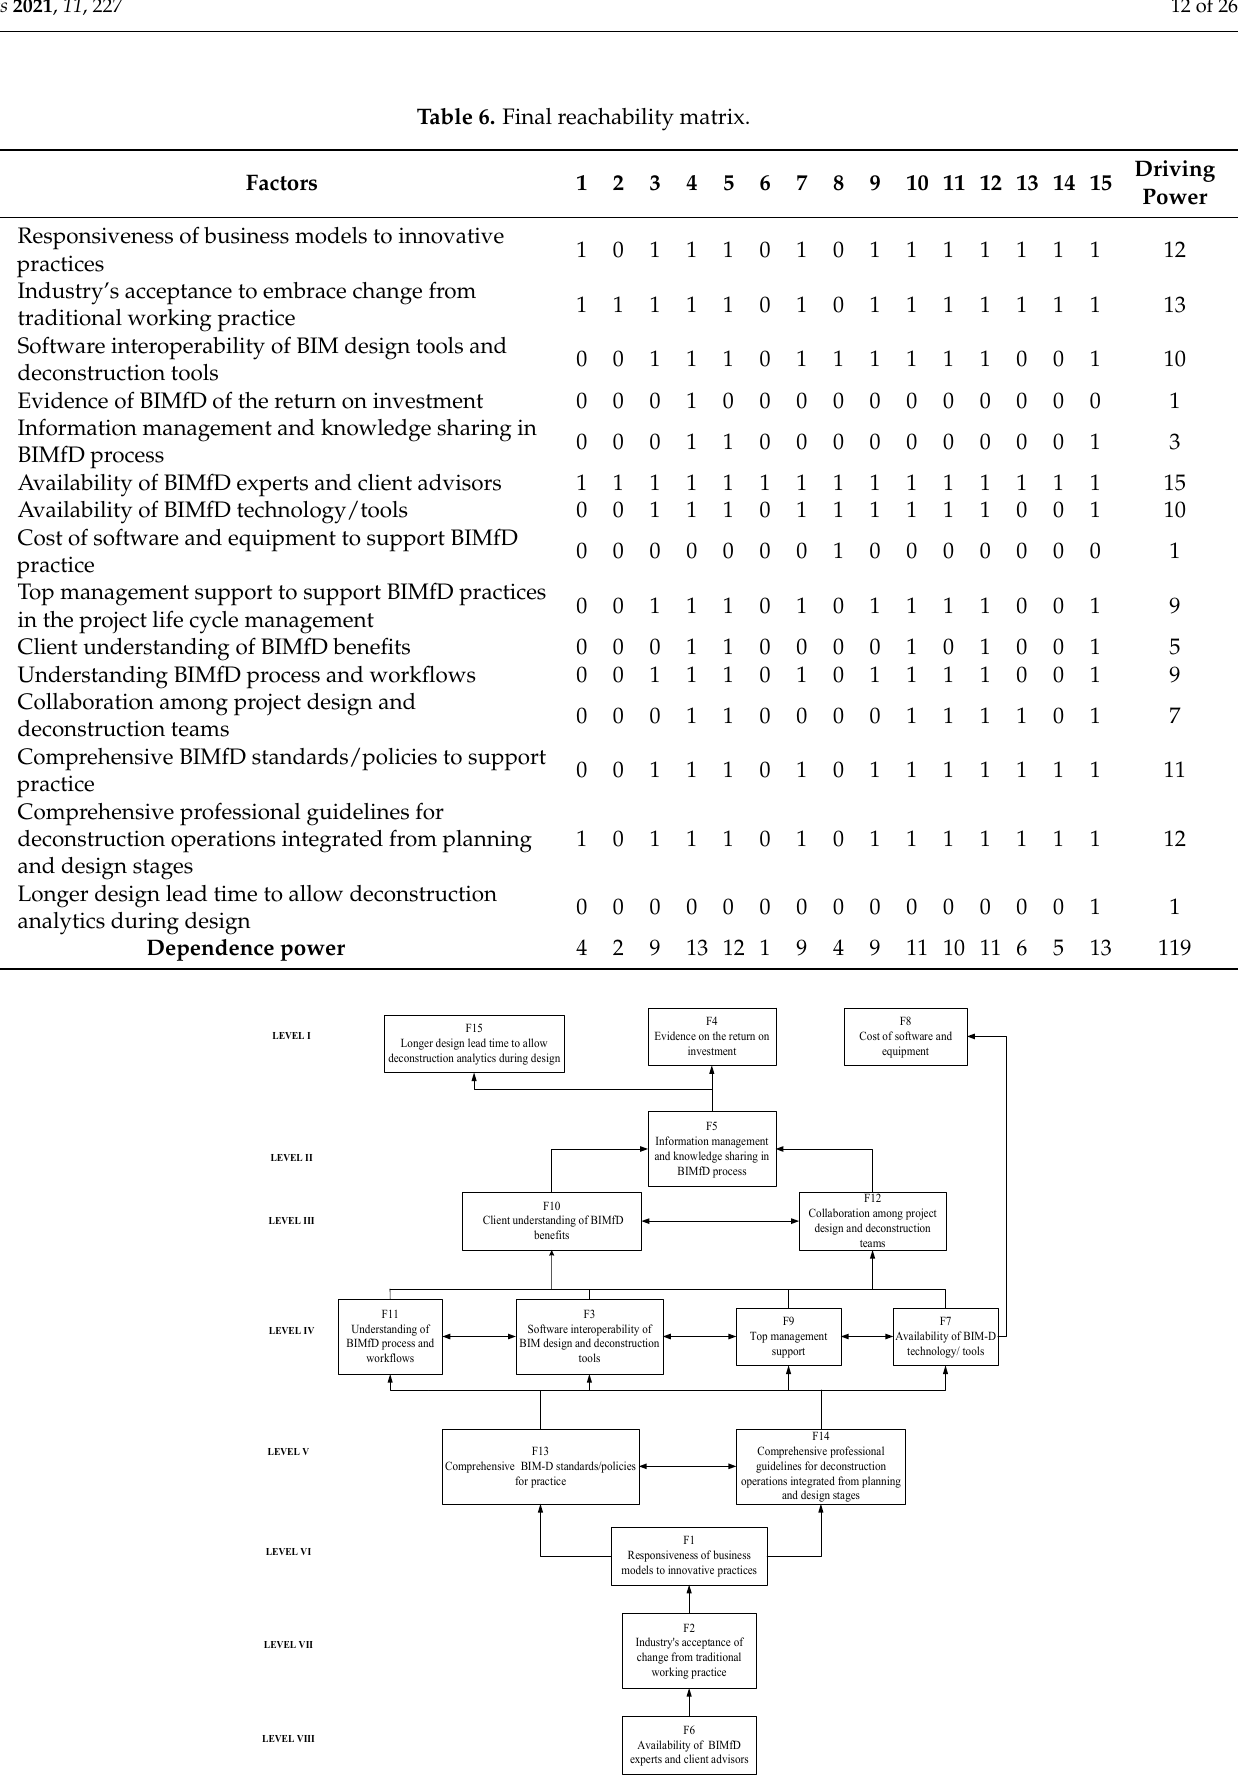
Figure 2. ISM BIMfD factor model.